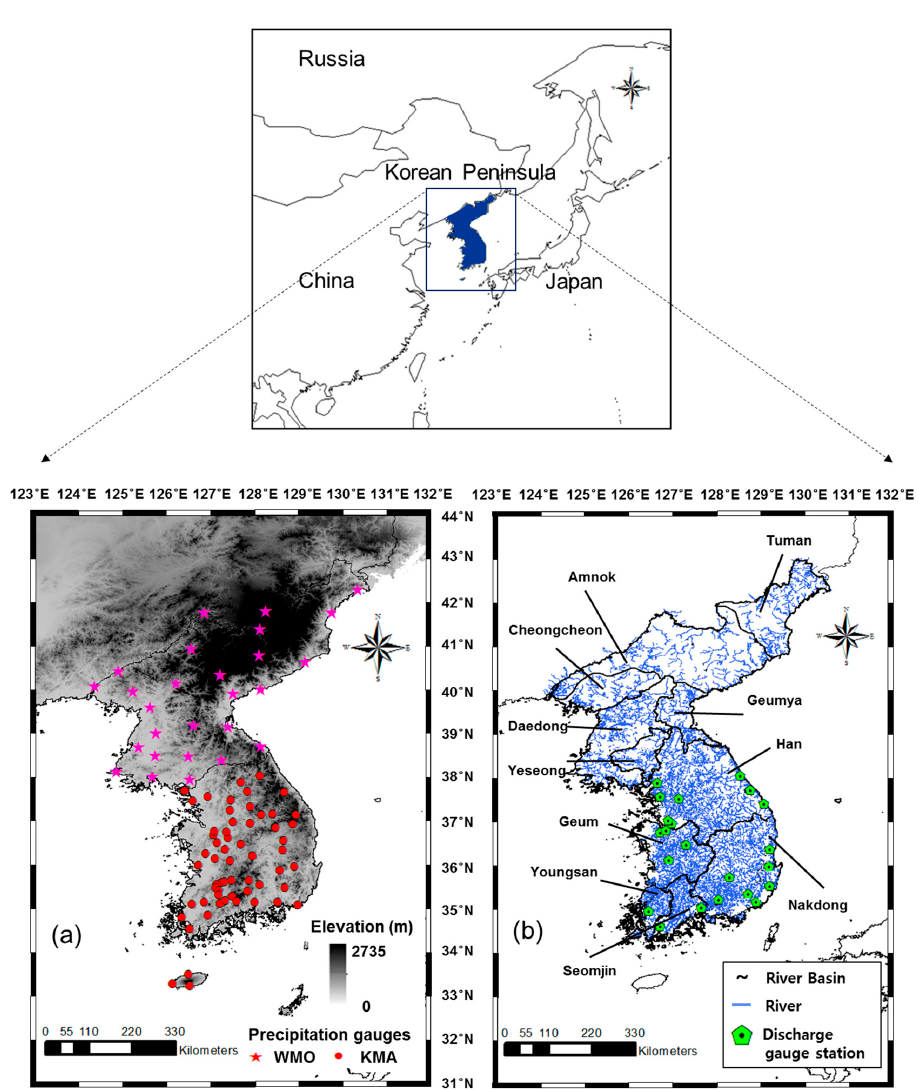
Figure 1. Location of the study area; ( a ) Digital Elevation Model (DEM) and Precipitation gauging stations; ( b ) Rivers, basins and discharge gauging stations.